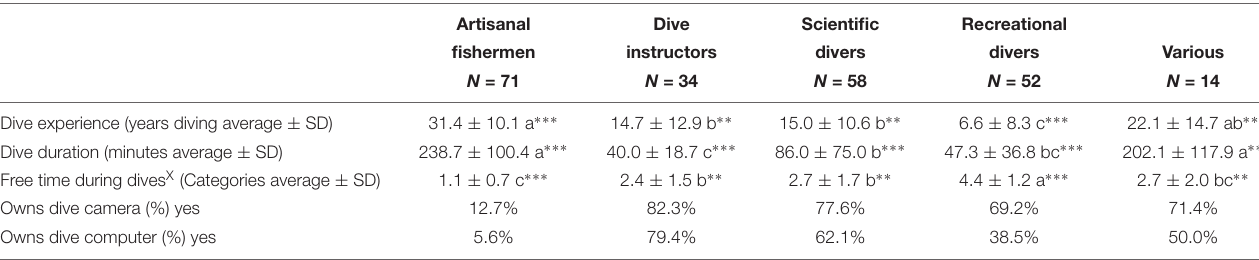
TABLE 3 | Diving profile by diver